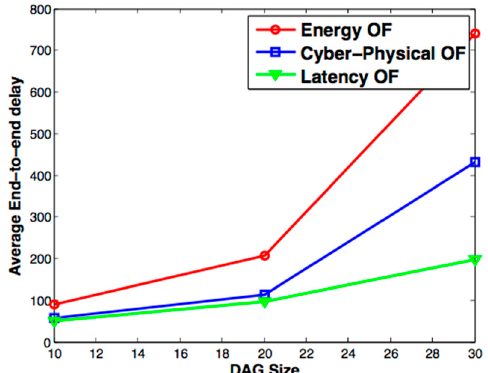
Figure 10. Average end-to-end delay of an energy-based objective function (energy-OF), a latency-based objective function (latency-OF), and the cyber-physical objective function (Cyber-OF), in relation to directed acrylic graph (DAG)